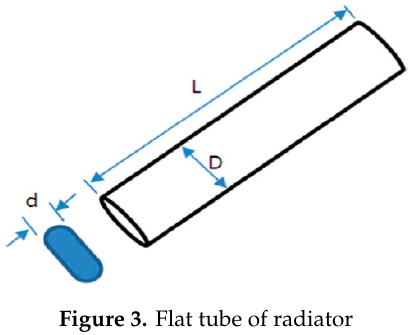
Figure 3. Flat tube of radiator